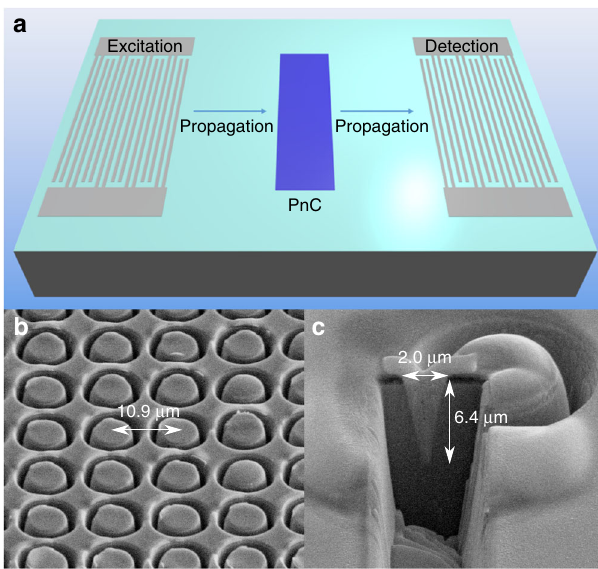
Fig. 3 SAW delay line and fabricated PnC. a Schematic of device used to characterize the PnC with excitation and detection inter-digital transducers and propagation direction. The blue shaded area represents the fabricated PnC which covers the transducer aperture. b Section of a 3 mm × 80 µ m square array of annular holes with depth 6.4 µ m, inner radius 3.1 µ m, outer radius of 5.1 µ m and pitch 10.9 µ m. c Cross section depth pro fi le of an individual annular hole with platinum within the hole to provide image contrast